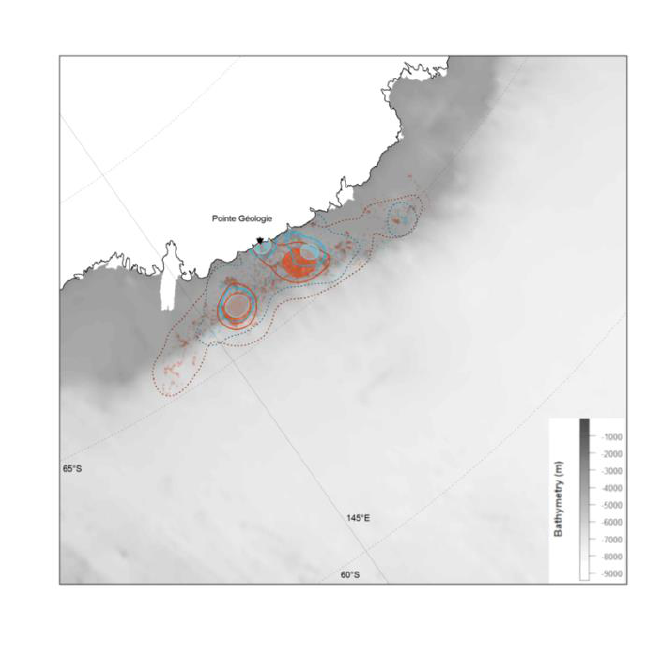
Figure 1. Foraging ranges of male (blue) and female (red) snow petrels during incubation sampled at Ile des Pétrels, Adélie Land, East Antarctica. Dots show raw location data. Kernel density based utilization distributions at 95% (dotted lines), 50% (solid lines) and 25% (filled areas). Bathymetry shown in grey and land in white. Ile des Pétrels is shown as a black